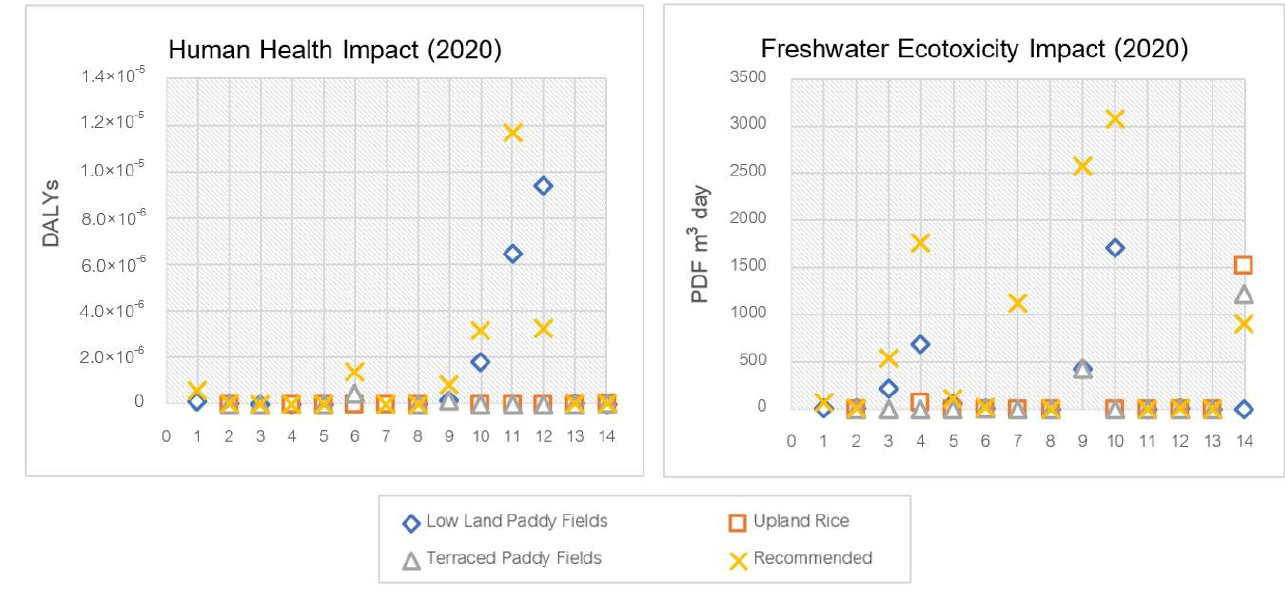
Figure 2 . Human health and ecotoxicity impact scores on pesticide use in rice cultivation in 2020 . 1 . Chlorpyrifos, 2 . Glyphosate, 3 . Acephate, 4 . Alachlor, 5 . Butachlor, 6 . 2,4 - D dimethyl ammonium, 7 . Fipronil, 8 . Metaldehyde, 9 . Mancozeb, 10 . Atrazine, 11 . Atrazine ( cancer ) , 12 . Acephate, 13 . Acephate ( cancer ) , and 14 . Carbendazim .